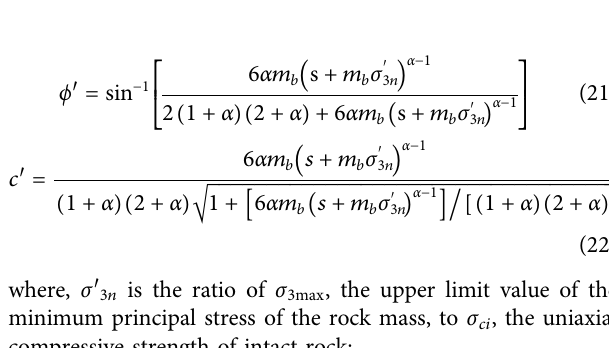
Frontiers in Earth Science |